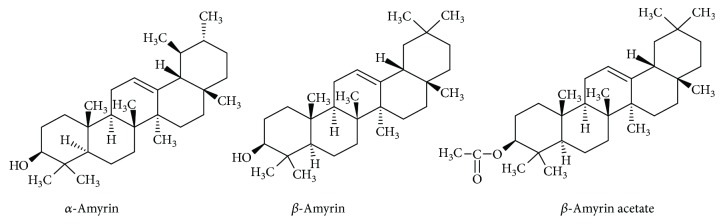
The examples of amyrins found in propolis [19, 20].